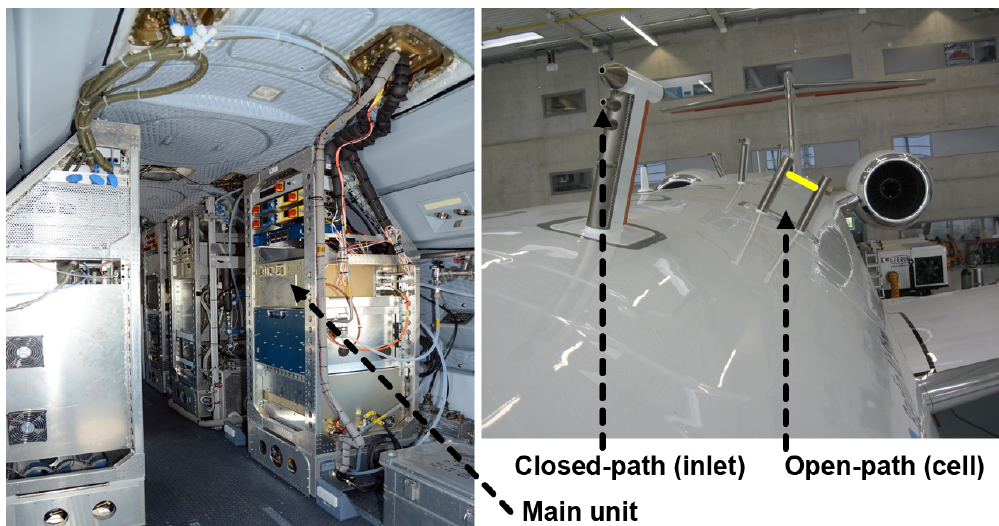
Figure 3. Photos of HALO’s cabin layout with installed payload for the TACTS/ESMVal campaign (left). Photo of HALO’s fuselage showing the trace gas inlet (TGI) for HAI’s closed-path cells (for total water detection) as well as HAI’s open-path cell (for gas-phase water detection; open-path laser beams are shown in